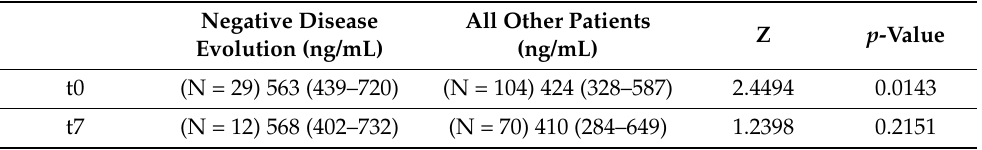
Table 2. Negative disease evolution. Patients’ follow-up and OPN levels correlation. The levels of OPN were assayed with ELISA at day 0 (baseline, t0) and at day 7 (t7) of hospitalization. The table resumes the correlation data between patients with negative disease evolution (in-hospital death or ICU admission) vs. all other patients. Values are expressed as median IQR. N, number of analyzed patients. Bold text evidence statistically significant results.